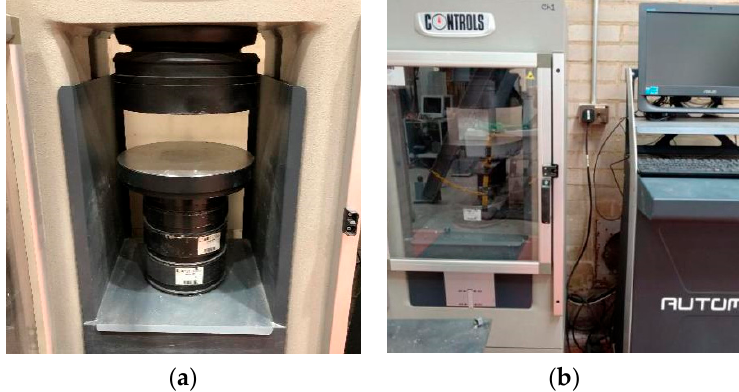
Figure 5. ( a ) Compressive test setup; ( b ) Controls Automax machine for the compressive strength tests.